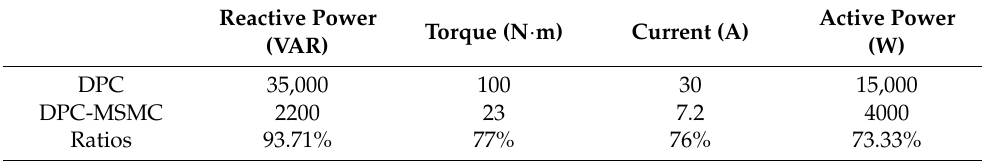
Table 6. Comparison of ripple values between the designed and the conventional DPC strategy (robustness